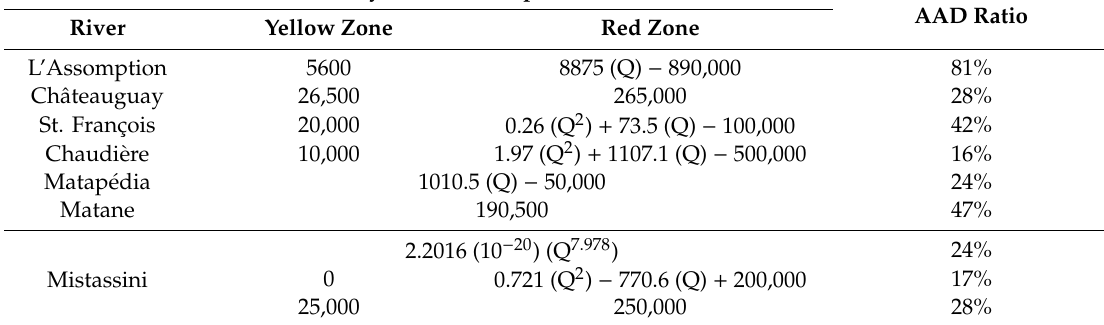
Table 5. Damage values or equations associated with dynamic breakup events (including one or multiple simultaneous ice jams for a given runo ff event) for each studied river. The last column represents the total cost of ice-jam floods for each river for the period of 1991 to 2014 divided by the calculated potential cost (using the previous two columns) of all the dynamic breakup events during the same period.